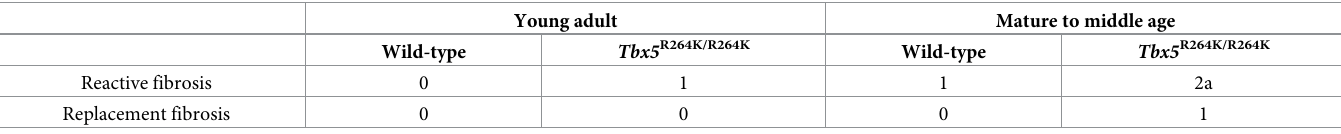
Table 3. Semi-quantitative evaluation of myocardial fibrosis based on S2 Table in wild-type and Tbx5 R264K/R264K